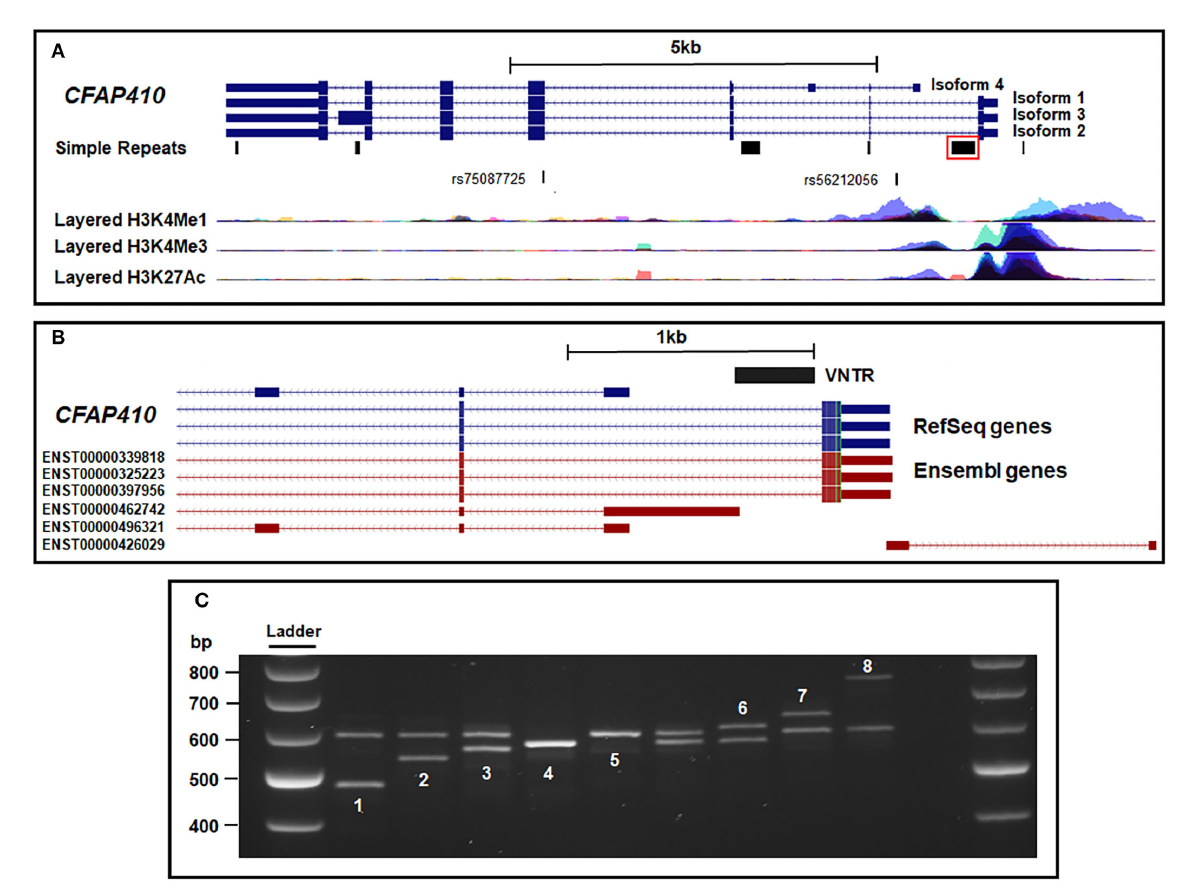
FIGURE1 Location of multiple transcripts at the CFAP410 gene locus relative to the intron 1 VNTR. (A) The four main isoforms of CFAP410 overlaid with the Simple Tandem Repeats track and histone marks from the ENCODE database. The ALS GWAS SNP (rs75087725) and identified tagging SNP (rs56212056) are also shown. The VNTR identified in this study is boxed in red. (B) CFAP410 VNTR location overlaid with RefSeq genes from NCBI and predicted transcripts from Ensembl database. (C) PCR amplification and gel electrophoresis of the VNTR within the CFAP410 locus. This region was confirmed to be polymorphic and eight alleles were identified (numbered 1–8 to reflect increasing length). Variant 7 was found only in a single ALS case. All samples were run at 100V on 2% agarose for 3.5h. All samples shown are from the cohort of ALS cases and controls that are genotyped in Table